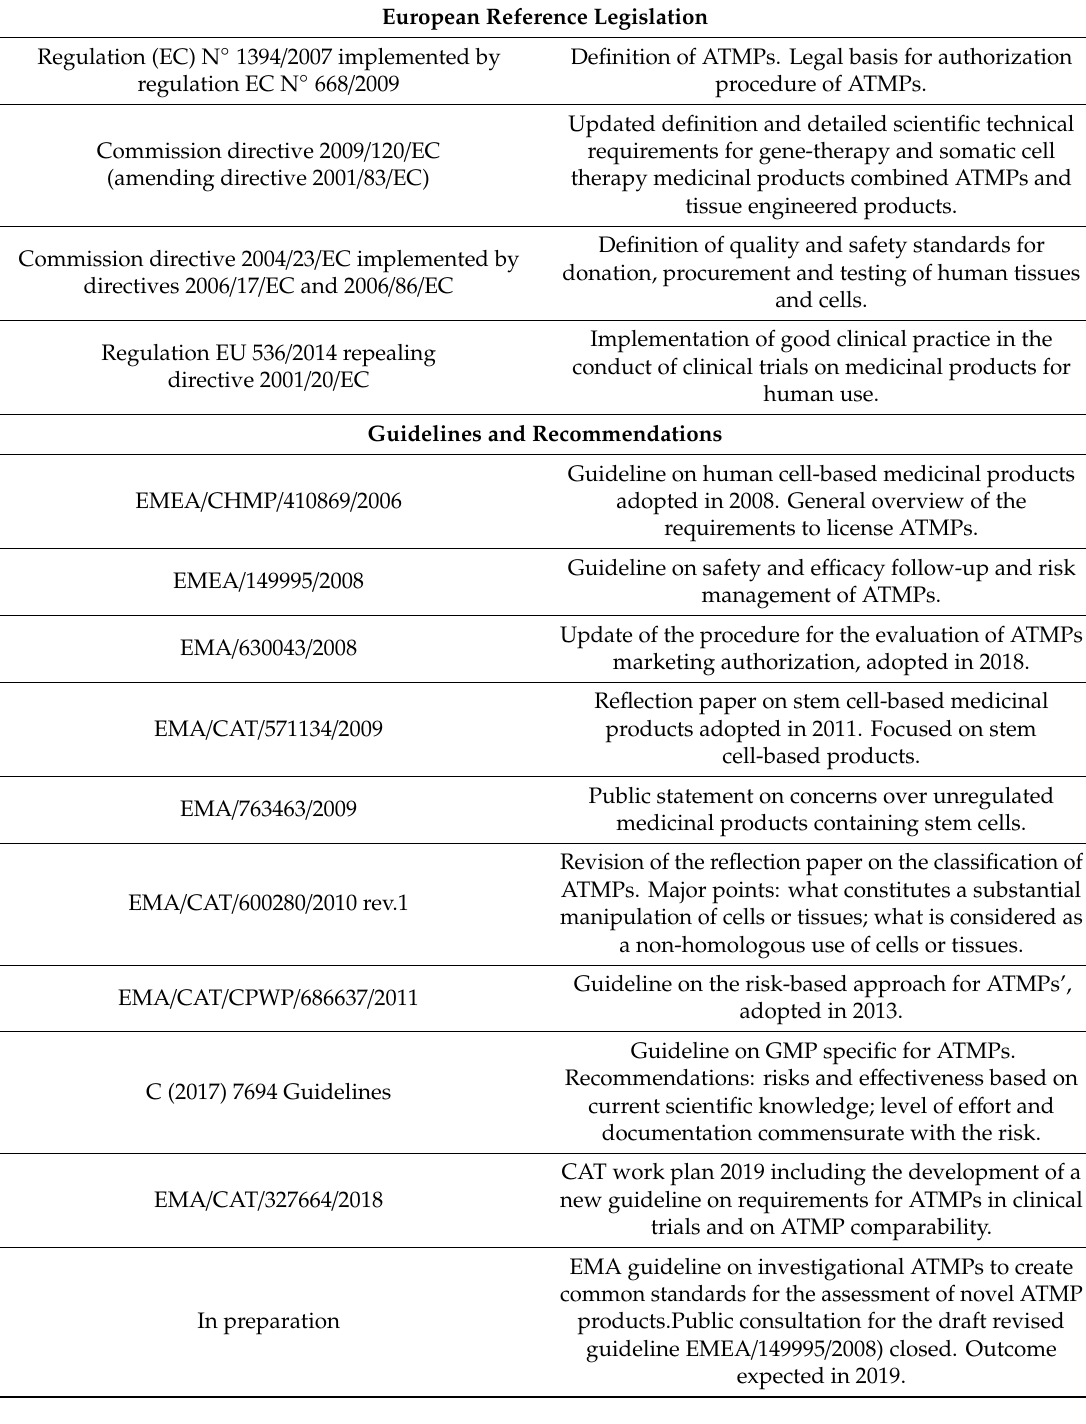
Table 2. The European regulatory framework on Advanced Therapy Medicinal Products